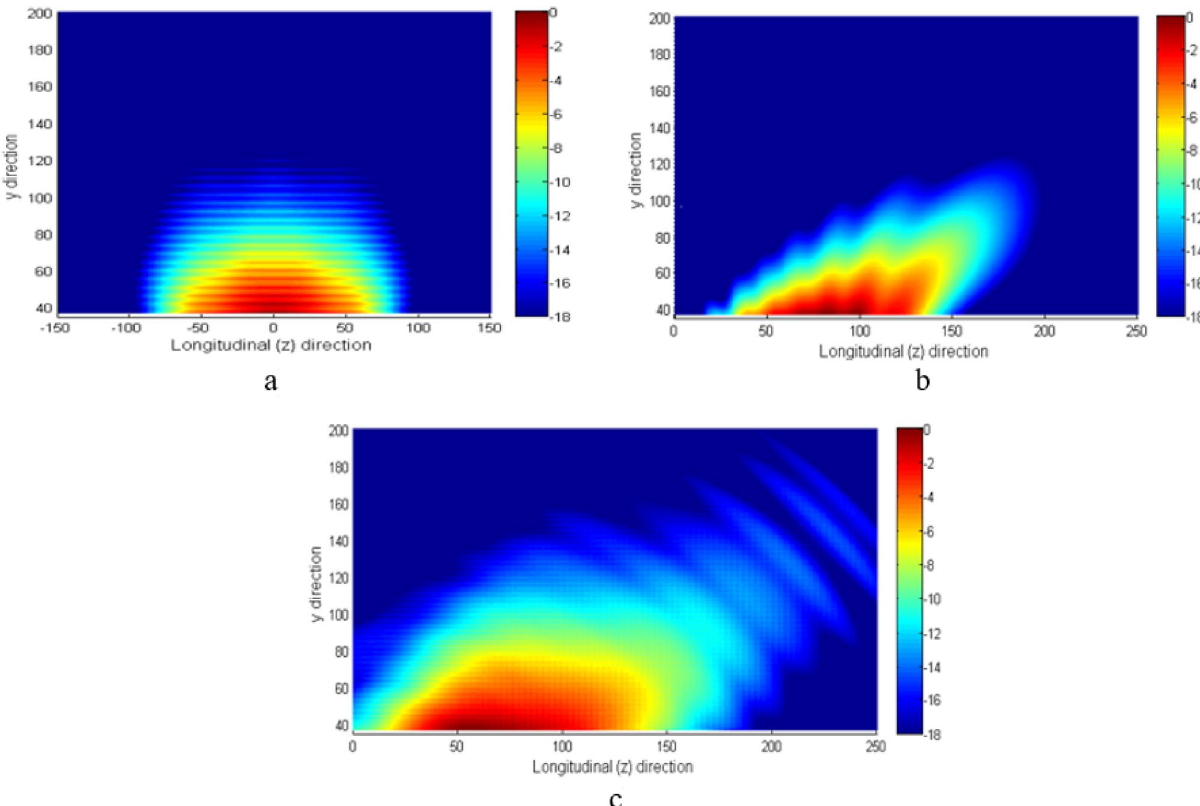
Figure 8. Electric field in the lossy medium produced by the ( a ) horn, ( b ) LWA and ( c ) HTwLP. The field was computed in dB from the highest amplitude of the field at the interface. The lossy medium is positioned at y = 37.5 mm. Dimensions are in